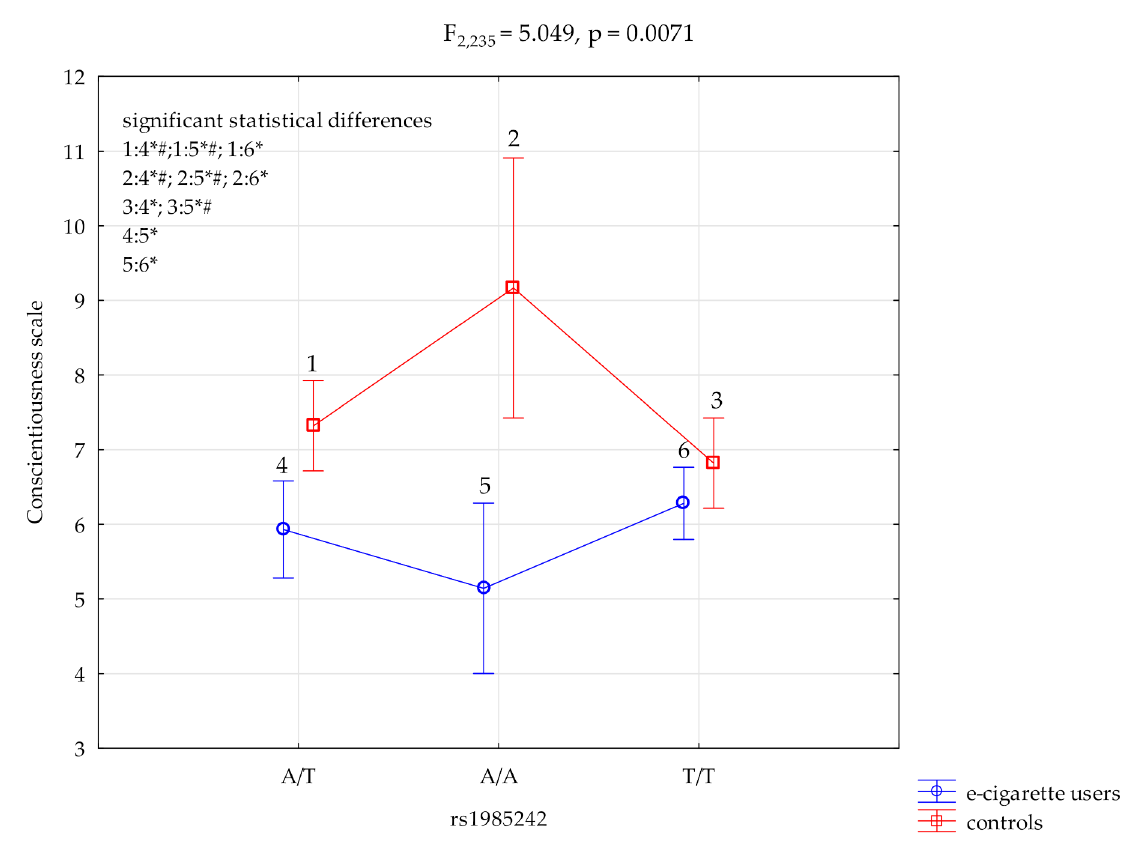
Figure 1. Interaction between e-cigarette users/controls, HTR3A rs1985242 and conscientiousness scale. * significant statistical differences, # Bonferroni correction was used, and the p value was reduced to 0.0083 ( p = 0.05/6 (number of statistical tests conducted)).